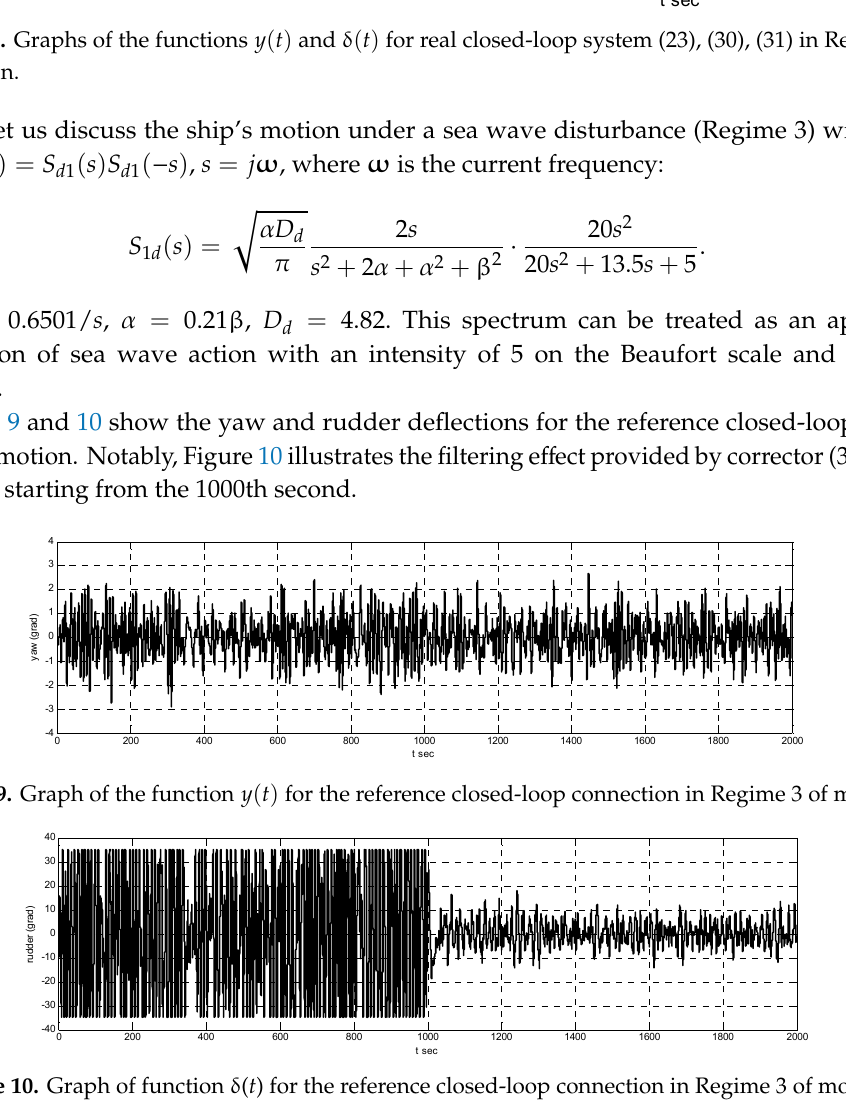
Figure 10. Graph of function δ ( t ) for the reference closed-loop connection in Regime 3 of motion. Figure 10. Graph of function )( t δ for the reference closed-loop connection in Regime 3 of motion. For the real system with a time delay, a graph of the rudder deflection for the closed-loop J. Mar. Sci. Eng. 2020 , 8 , 477 connection (23), (30), (31) is shown in Figure 11. Figure 10. Graph of function )( t δ for the reference closed-loop connection in Regime 3 of motion. Figure 10. Graph of function )( t δ for the reference closed-loop connection in Regime 3 of motion. For the real system with a time delay, a graph of the rudder deflection for the closed-loop For the real system with a time delay, a graph of the rudder deflection for the closed-loop connection (23), (30), (31) is shown in Figure 11. connection (23), (30), (31) is shown in Figure 11.